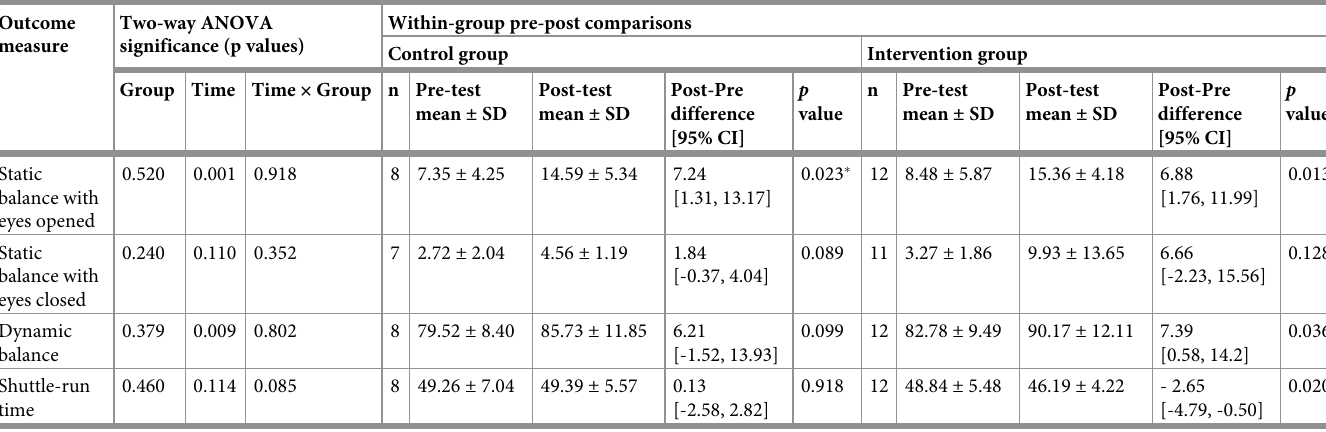
Static balance with eyes opened, static balance with eyes closed and shuttle run time are measured in seconds. Dynamic balance represents the normalized reach distance which is expressed as a percentage of leg length.